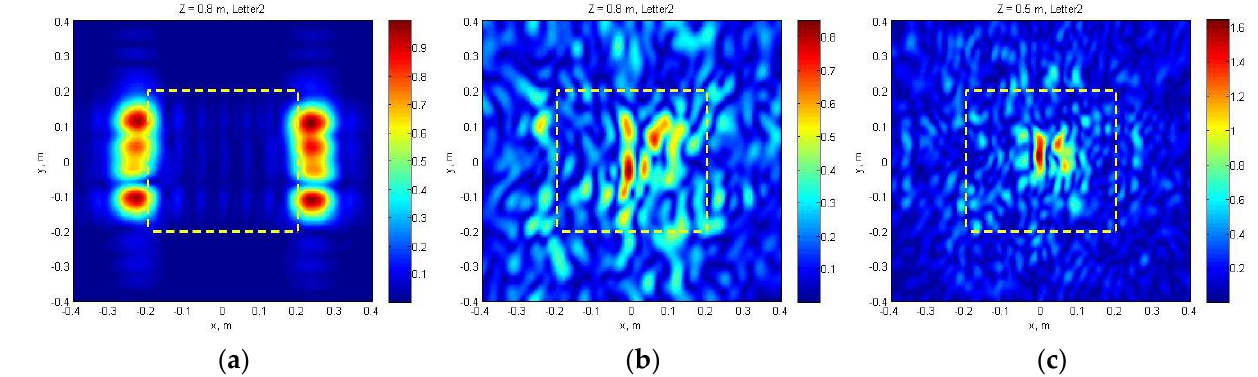
Figure 16. Coherent image of six radiation sources in the plane of specular reflection z = 0.8 m ( a ); “biting off” Gaussian imaginary sources ( b ); migration to the object plane z = 0.5 m ( c ). Dotted line—HSR contour.